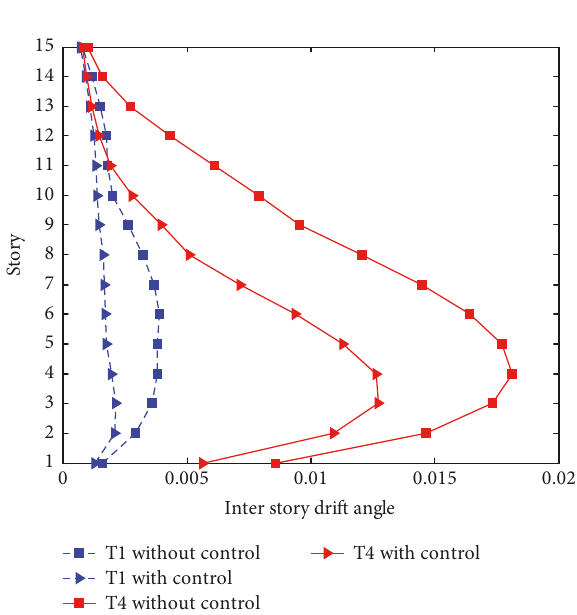
Figure 22: Acceleration time history of different earthquakes.